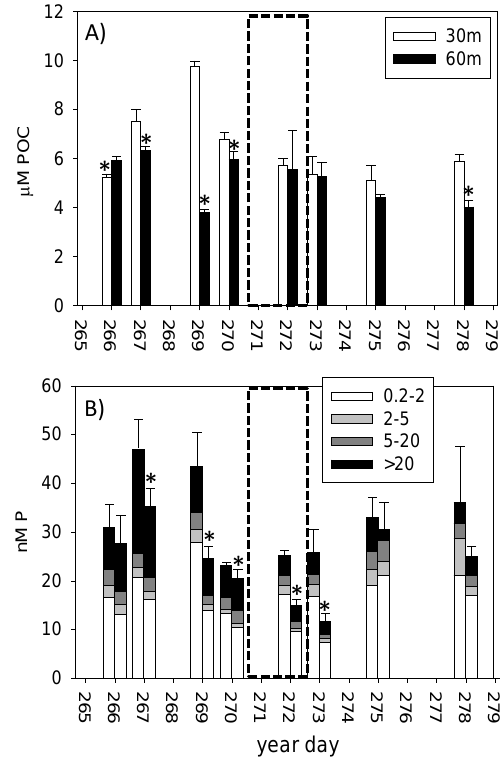
Fig. 1. Size-fractionated and total oxalate-washed particulate P (P) from ICPMS analyses and particulate organic carbon (POC) by elemental analyzer at 30 and 60m over the course of the ex- periment. (A) µM POC, > 0.7µm; left bar (white)=30m, right bar (black)=60m. (B) nM P (oxalate-washed) by size fraction. Stacked data represent (top to bottom) the > 20µm, 5–20µm, 2–5µm, and 0.2–2µm fractions; left bar=30m, right bar=60m. The transition between the two phases of the study (bloom inside the eddy and postbloom outside the eddy) is marked by the dashed line rectan- gle. Error bars represent 1 standard deviation ( n = 3). Significant differences between 30m and 60m values are designated by an as- terisk ( p < 0 .